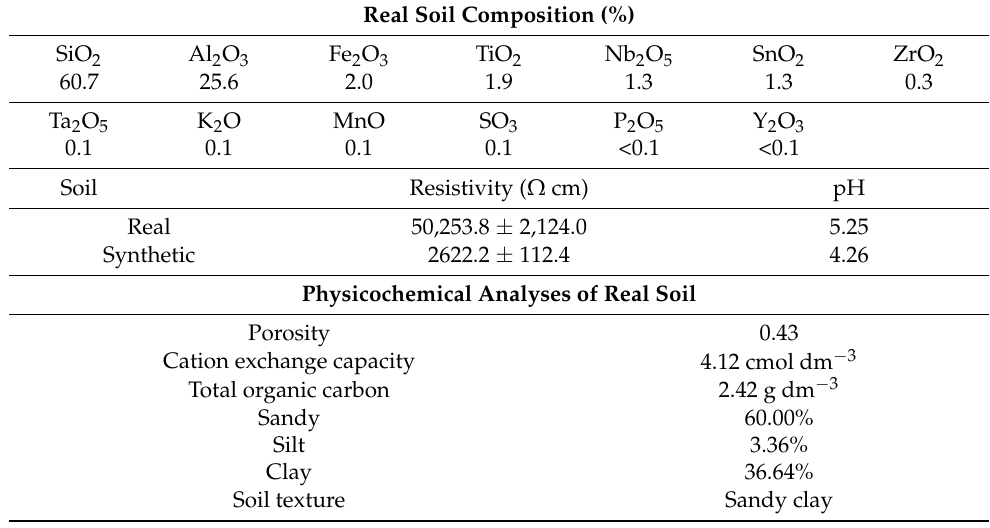
Table 1. The physicochemical analyses of the real and synthetic soils.